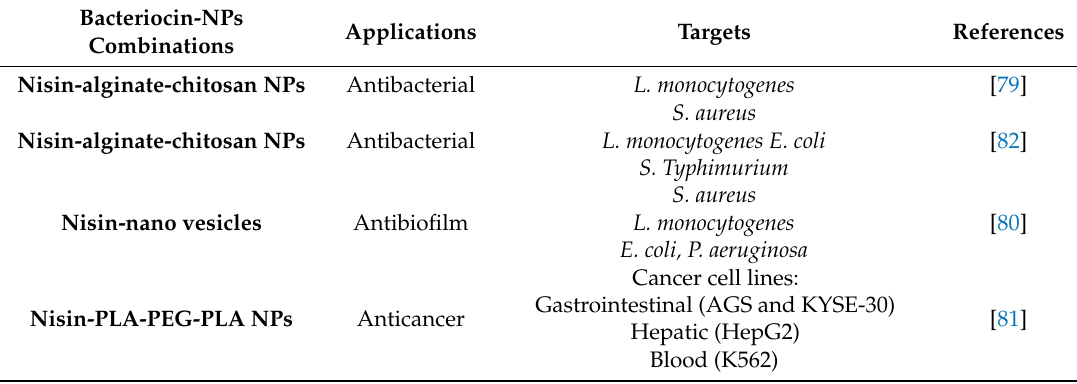
Table 3. Synergistic e ff ects of combining nisin and NPs against various